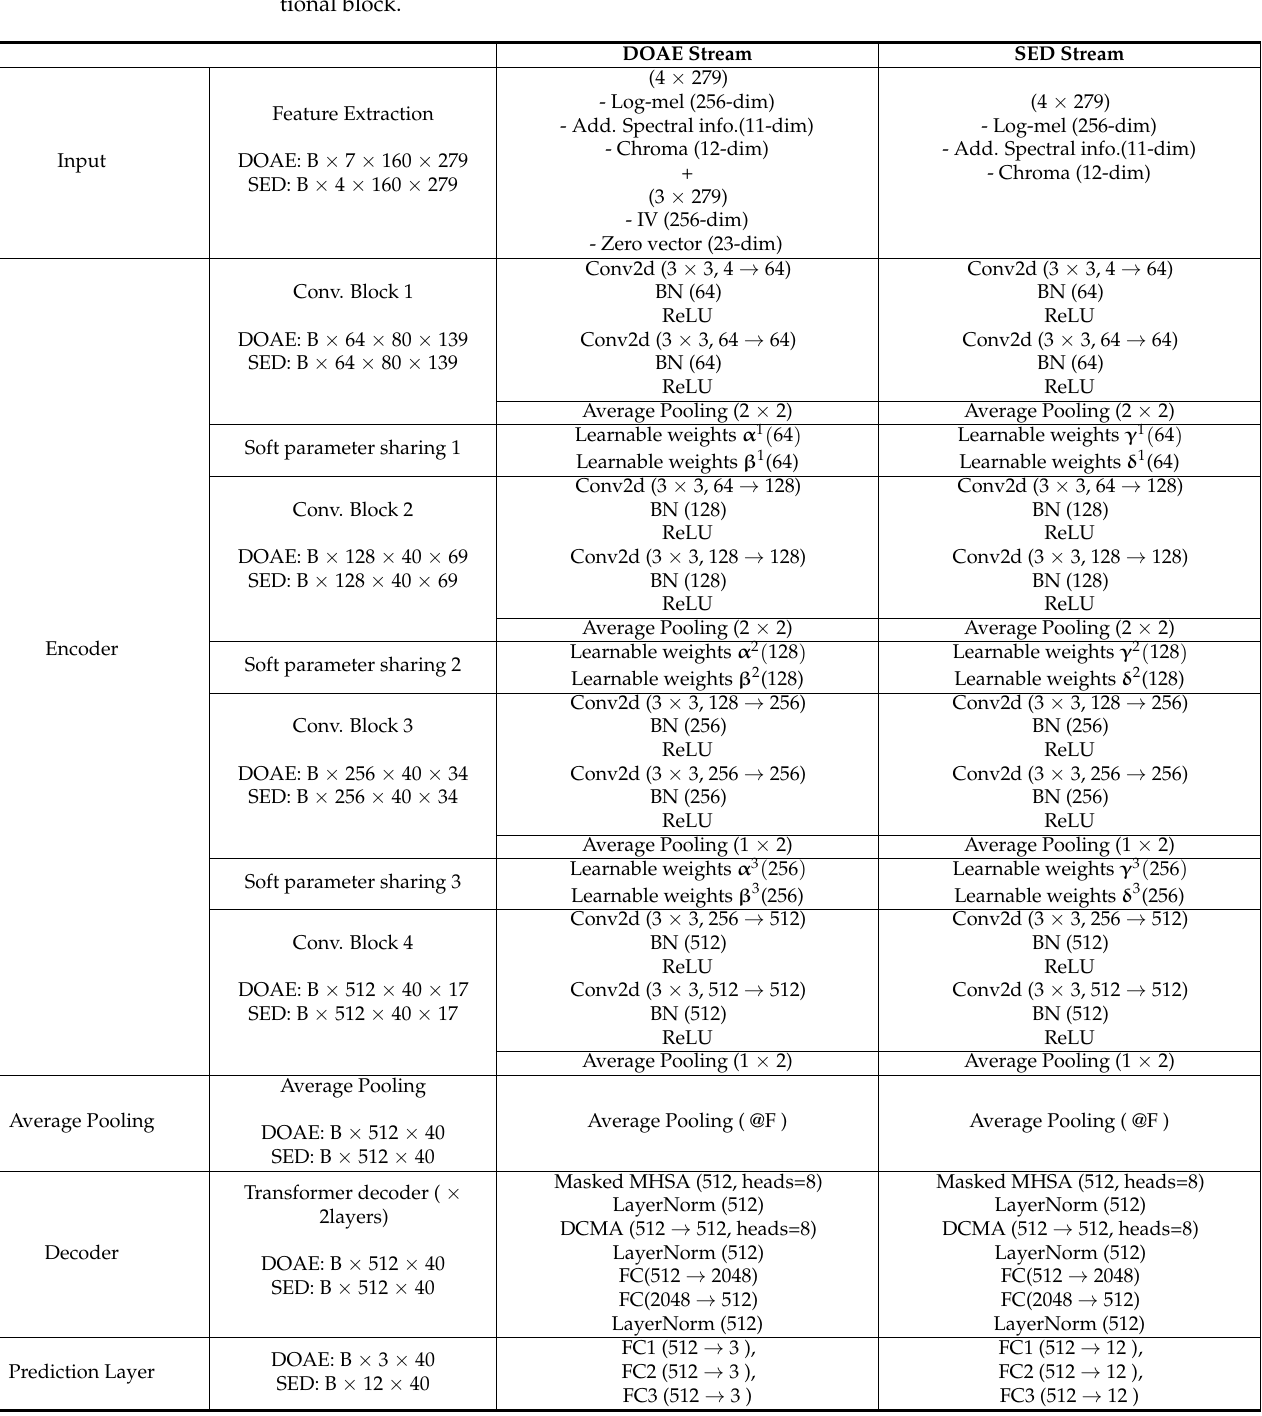
Table 2. Feature dimensions and hyper-parameters of DCMA-SELD. α i , β i , γ i , and δ i denote the learnable weights for the soft parameter sharing on the input embeddings for the i -th convolu- tional